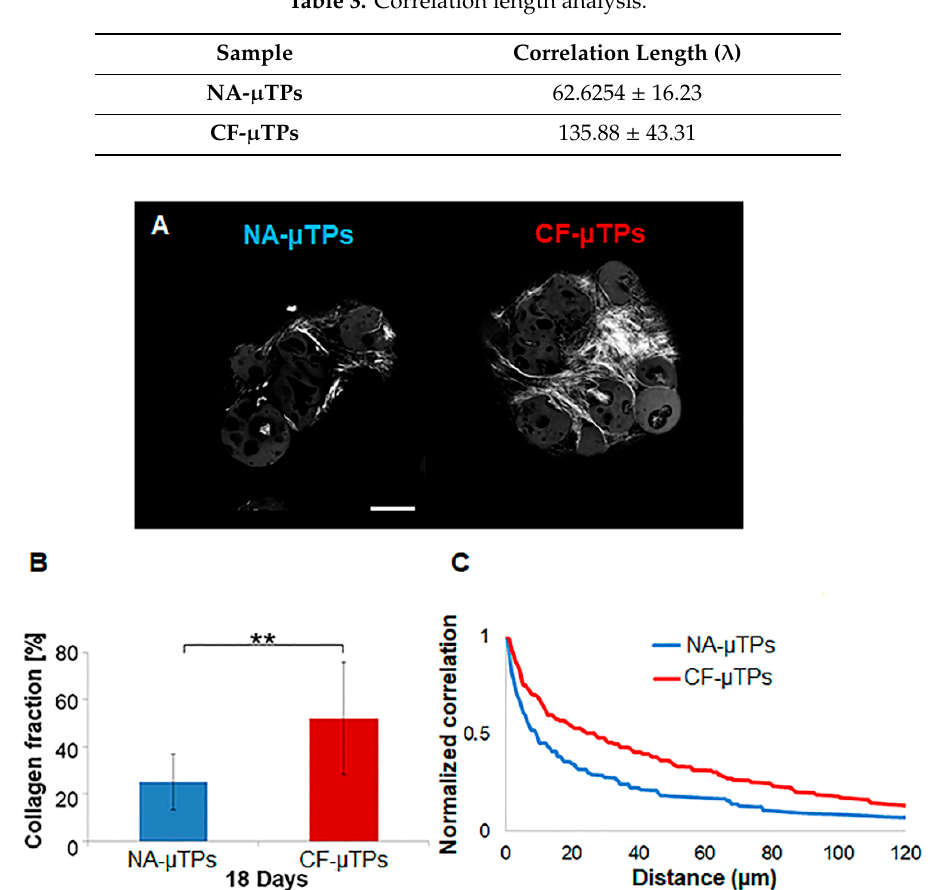
Figure 3. µ TPs morphological characterization: ( A ) Second harmonic generation (SHG) images of collagen fibers (shiny gray) in normal and cystic fibrosis micro-tissues (NA- µ TPs and CF- µ TPs); ( B ) Diagram of the collagen fraction (%) in NA- µ TPs (bleu) and CF- µ TPs (red), data are showed as Mean ± Standard Deviation; ( C ) Graphic of the normalized correlation obtained analyzing SHG images of NA- µ TPs (blue) and CF- µ TPs (red).